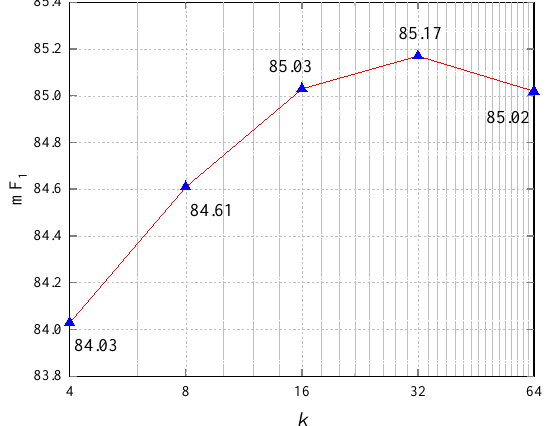
Figure 5. Evaluation on the influence of the search region k .